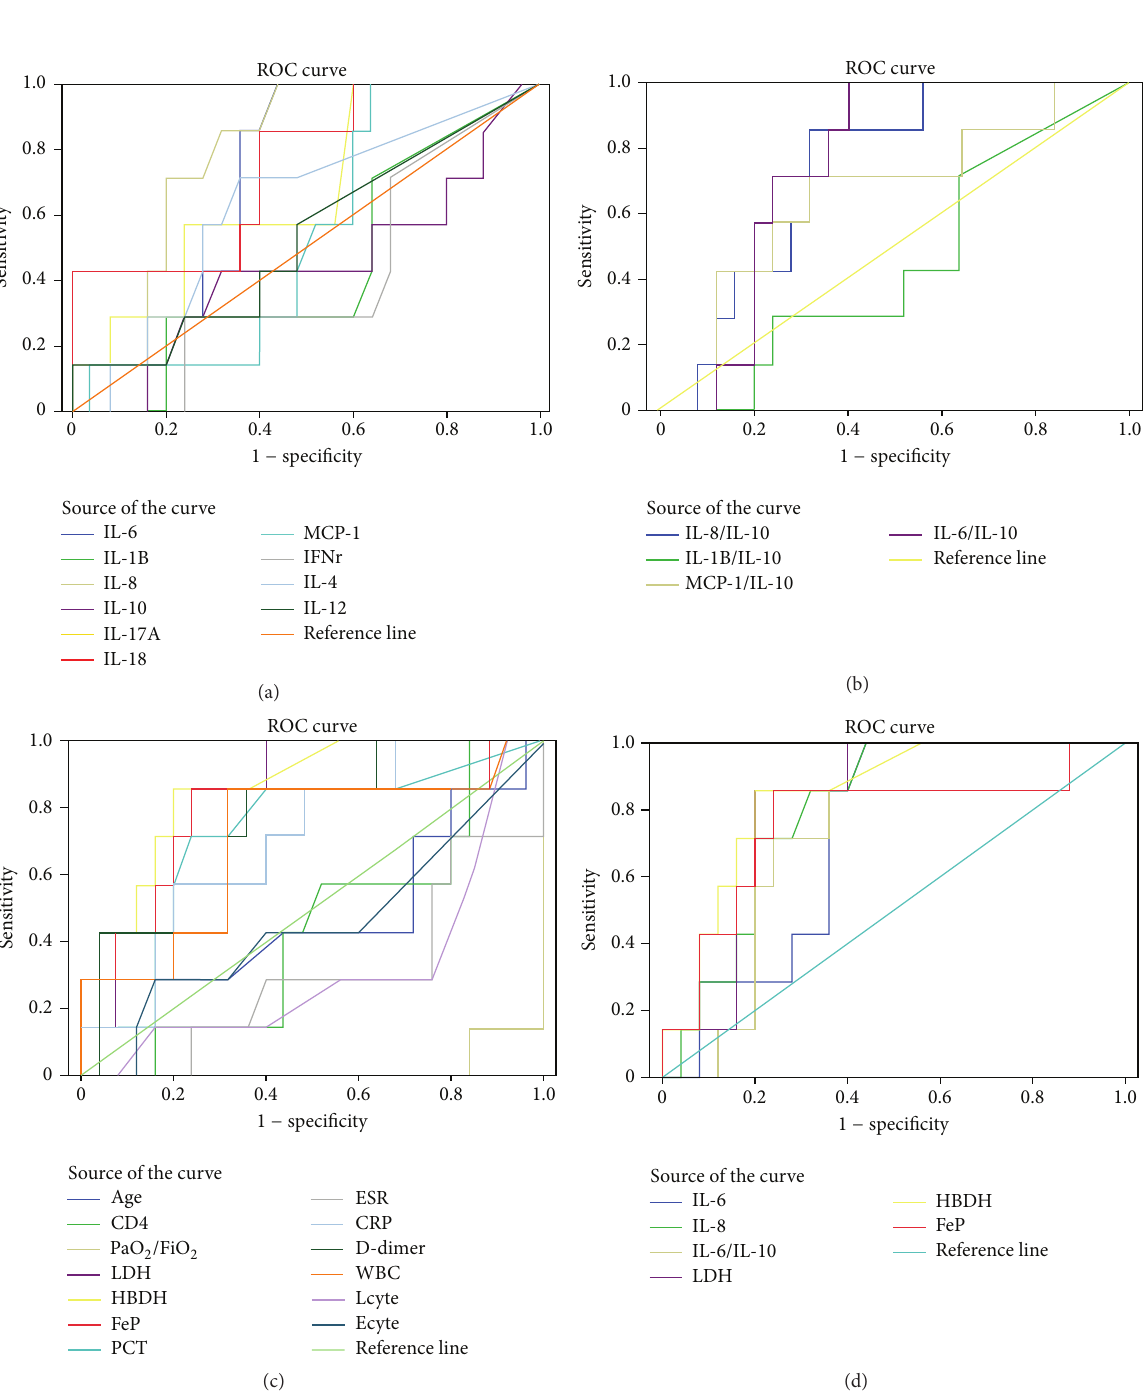
Figure 3: Receiver operating characteristic (ROC) curve analysis of biomarkers in nonsurvivors ( 𝑁 = 7 ) and survivors ( 𝑁 = 25 ) AIDS PCP. (a) LDH (95% CI 0.675–0.970, 𝑃 = 0.010 ), HBDH (95% CI 0.797–0.989, 𝑃 = 0.006 ), and FeP (95% CI 0.541–0.991, 𝑃 = 0.034 ) showing much higher AUC in nonsurvivors AIDS PCP groups. (b) IL-6 (95% CI 0.547–0.898, 𝑃 = 0.075 ) and IL-8 (95% CI 0.647–0.953, 𝑃 = 0.017 ) showing much higher AUC in nonsurvivors AIDS PCP groups. (c) IL-8/IL-10 (95% CI 0.561–0.963, 𝑃 = 0.057 ) and IL-6/IL-10 (95% CI 0.592–0.917, 𝑃 = 0.043 ) showing much higher AUC in nonsurvivors AIDS PCP groups. (d) Much better six biomarkers’ ROC curves shown together (WBC: white blood cell; LDH: lactate dehydrogenase; HBDH: hydroxybutyrate dehydrogenase; IL: interleukin; MCP-1: monocyte chemoattractant protein 1, and FeP: Ferritin